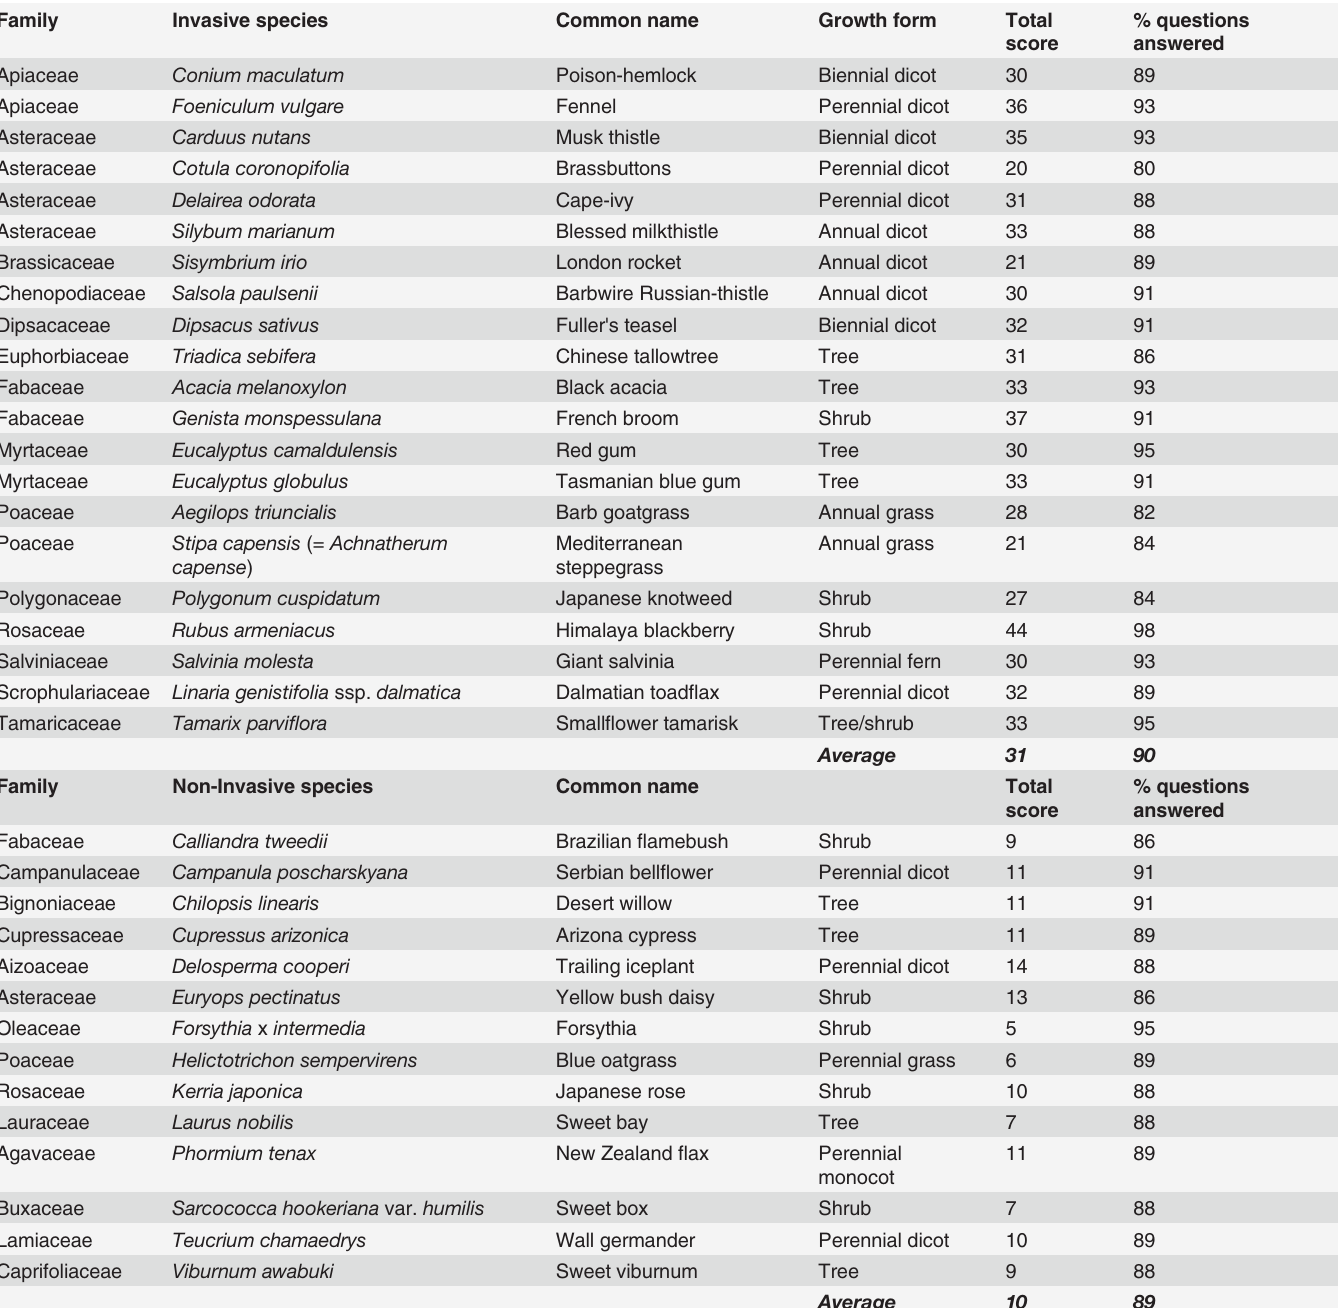
Table 1. List of plants evaluated with 56 questions and their total score and percentage of questions